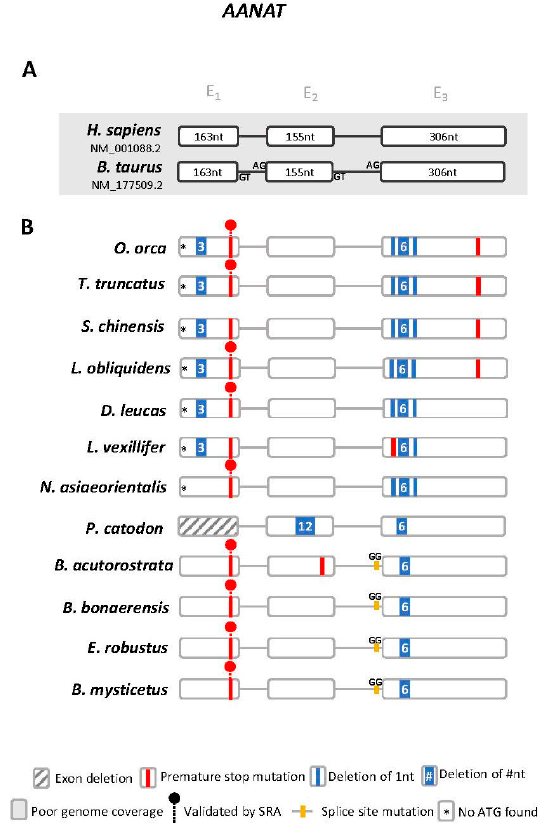
Figure 1. Aanat gene annotation. ( A ) Schematic representation of the gene structure of human and Bos taurus Aanat gene, each box represents an exon and lines represent intronic regions (not to scale). ( B ) Schematic representation of the corresponding Aanat genes identified in Cetacea and location of the identified mutations. Non-canonical splice sites are indicated above the corresponding annotation. SRA: sequencing read archives.